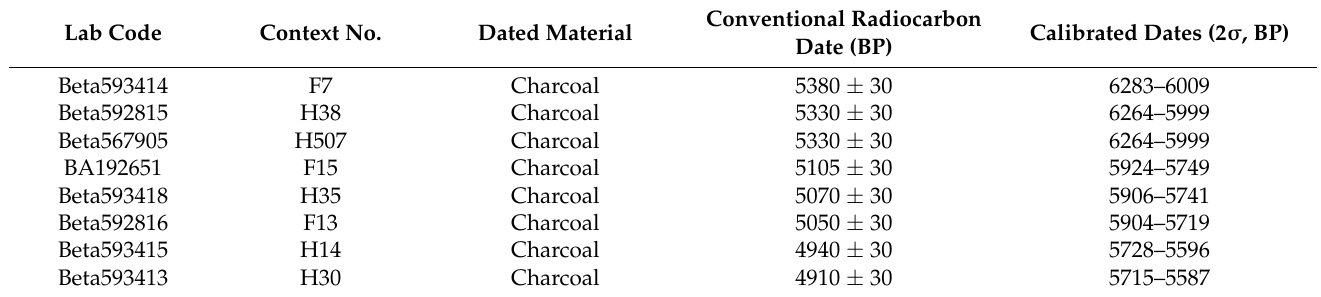
Table 1. AMS Radiocarbon dating results from the Zhangwangzhuang site (All dates are calibrated by OxCal v4.4.4, using the IntCal 20 Atmospheric curve). Context Lab Code No.